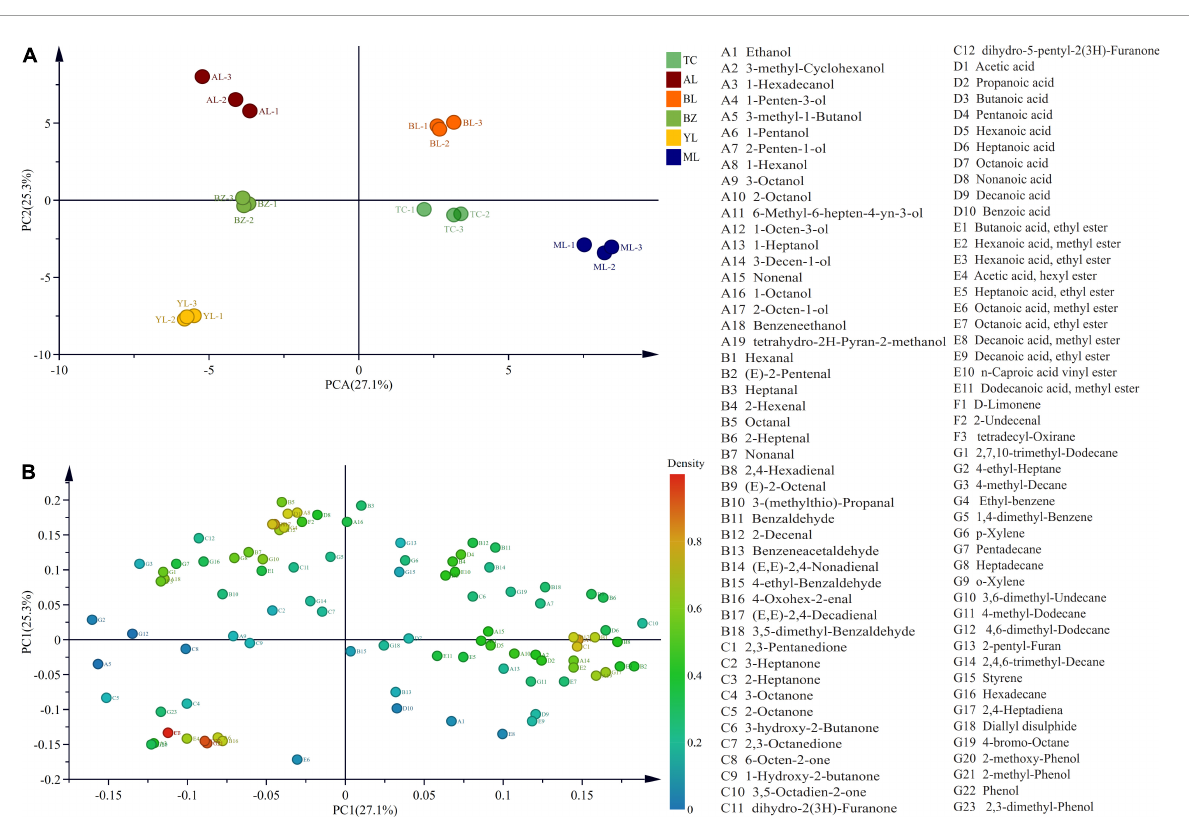
FIGURE5 Principal component analysis (PCA) score plot (A) and loading plot (B) of volatile compounds from horsemeat sausages from different